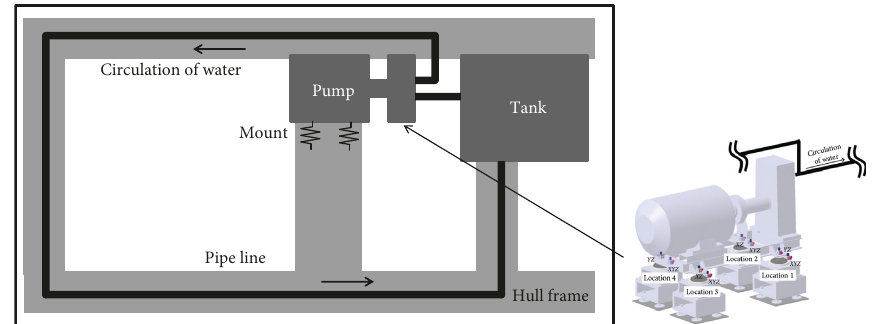
Figure 1: Overall schematic of target